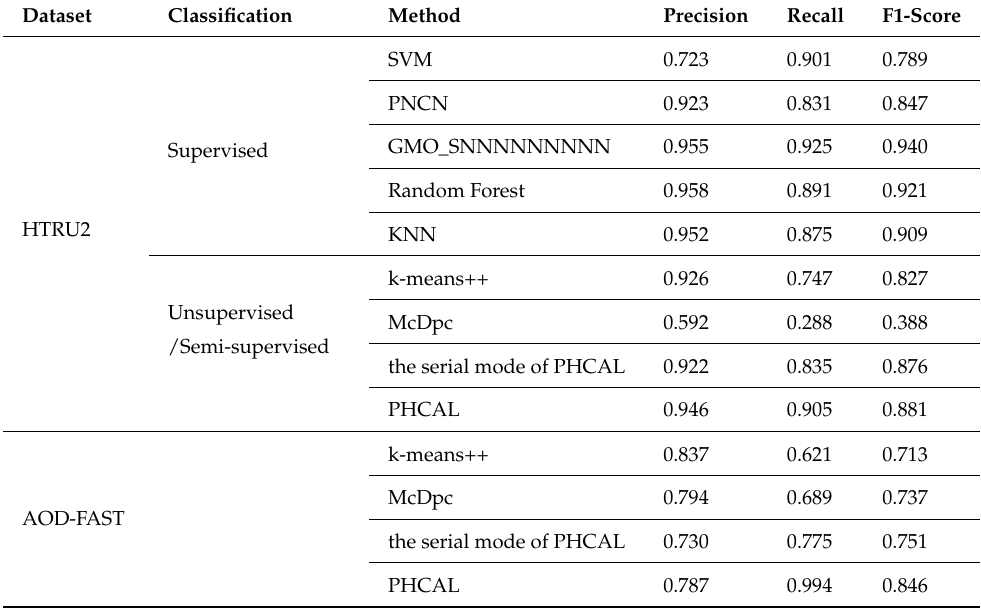
Table 7. Classification results with different methods for HTRU2 and